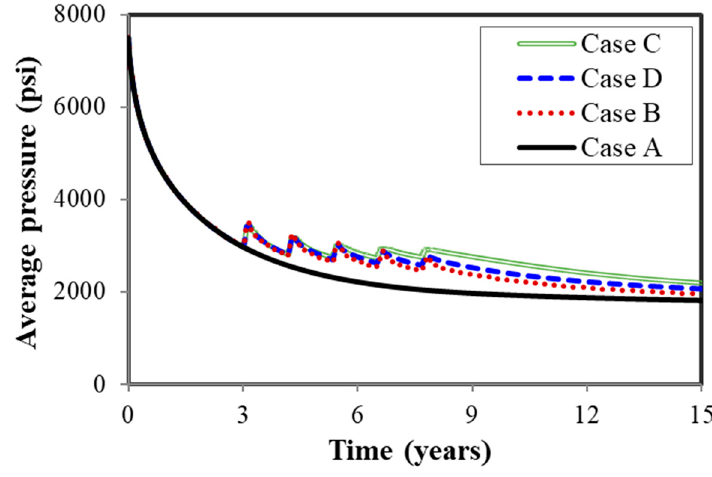
Figure 14. Average pressure of different scenarios.